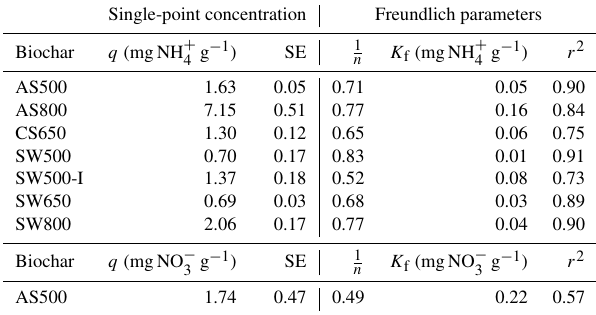
Table 3. Concentration of ions bound to biochars (mgNH NO − g − 1 ) at single-point concentration of 100mgL − 1 and Fre- 3 undlich model parameters ( n = 3). Nitrate parameters reported for only one biochar (AS500), as all other biochars released rather than removed NO − 3